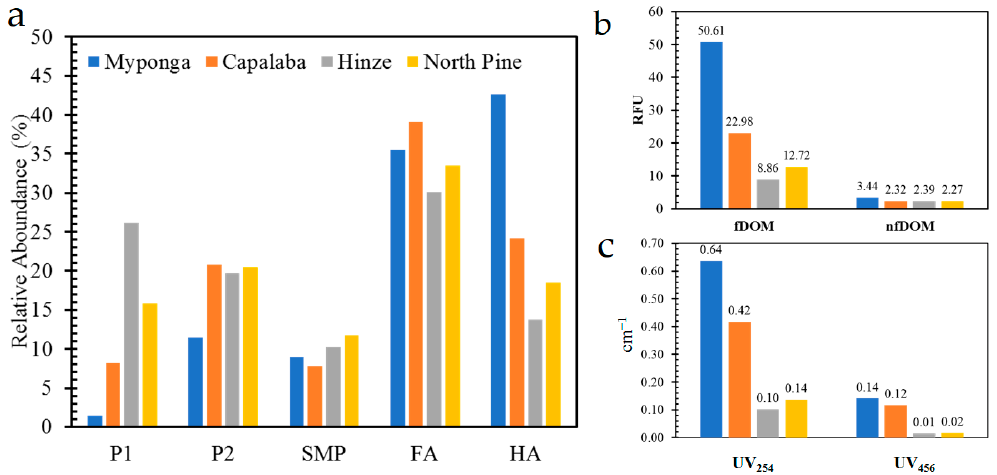
Figure 7. Excitation-emission matrix (EEM) of four raw waters. ( a ) Capalaba; ( b ) Myponga; ( c ) Hinze; and ( d ) North Pine.